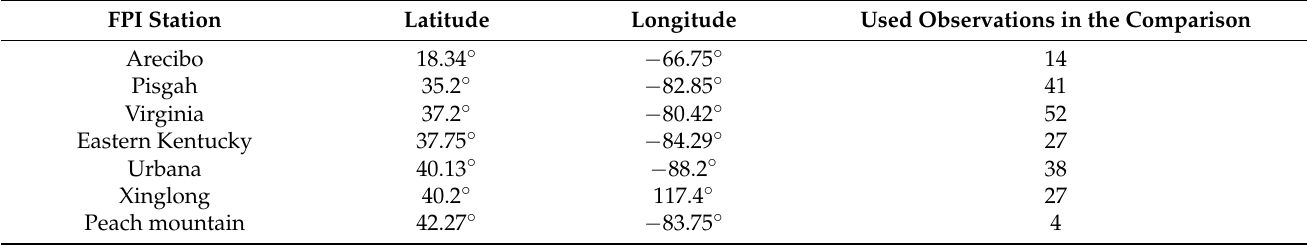
Table 1. Geographical locations of FPI stations and their number of selected observations. Positive latitude and longitude represent north and